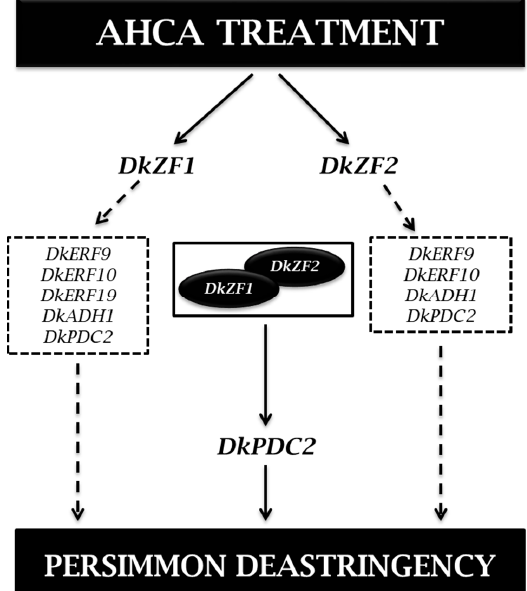
Figure 5. A proposed model of DkZF transcription factors (TFs) in response to AHCA treatment. AHCA treatment triggers the expressions of DkZF1 and DkZF2 transcription factors that transcriptionally regulate deastringency-related genes represented in dashed boxes respectively. On the other hand, DkZF1 and DkZF2 also form a protein complex and synergistically interact with the DkPDC2 promoter, and ultimately aid in persimmon fruit deastringency.